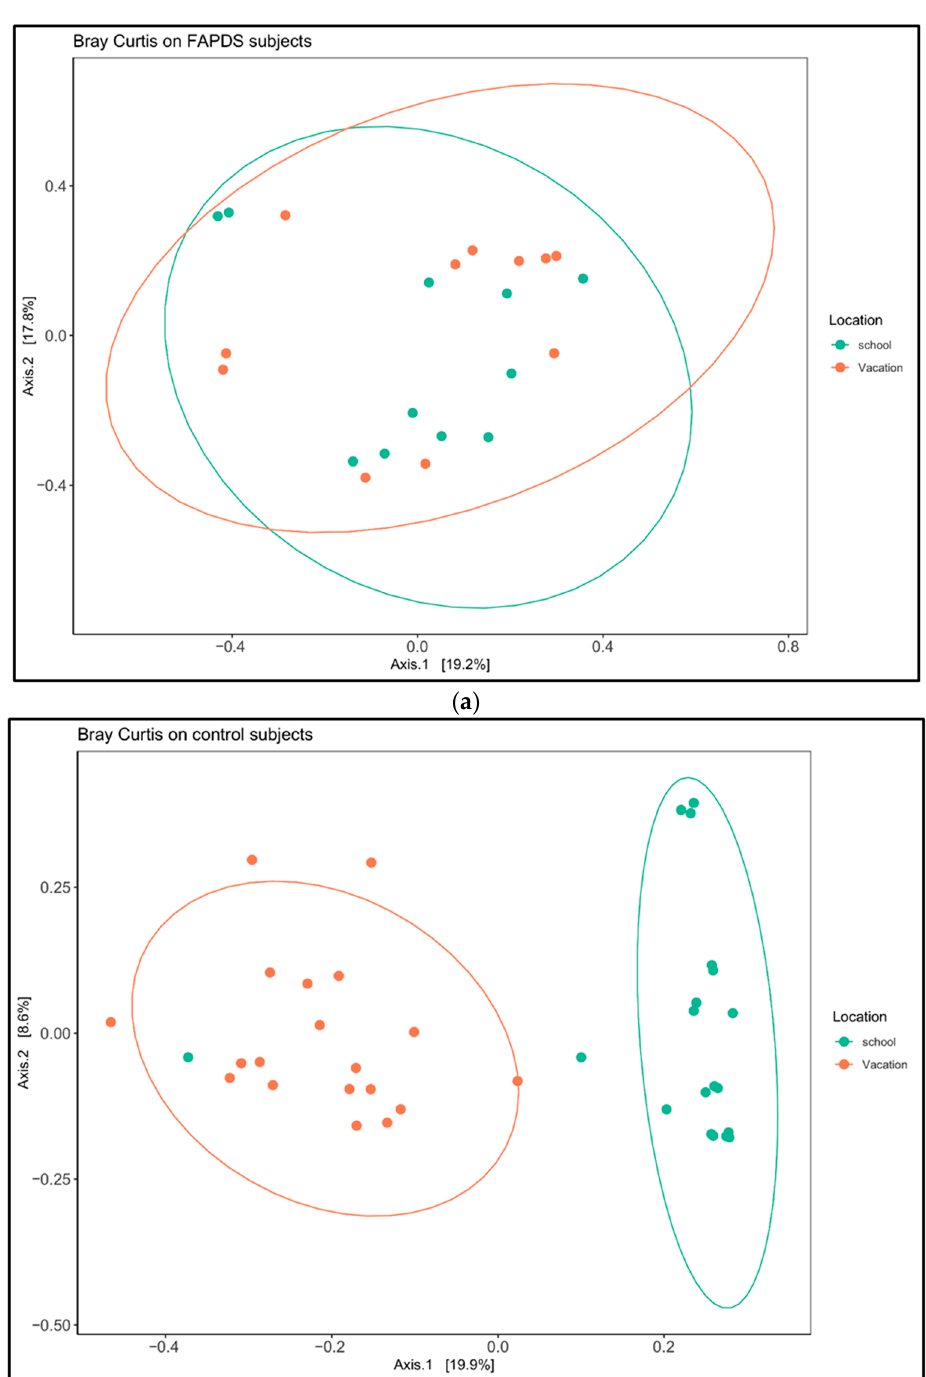
Figure 5. Beta diversity comparison in 11 paired FAPDs ( a ) patients and 19 paired control groups ( b ) at two different school terms. Bray–Curtis measurements showed statistical differences in the control group, while no statistical differences were observed in the FAPDs group.